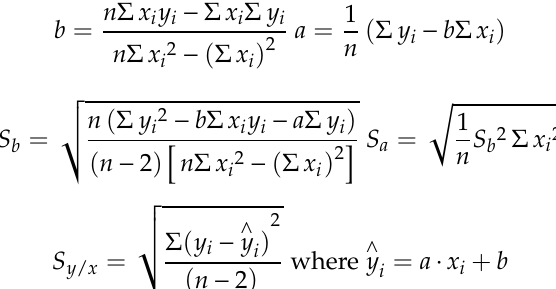
Figure 6. Emission spectrum of 3-aminoflavone in methanol at a concentration c = 0.1 µ g / mL in quartz cuvette with a thickness l = 1 cm. Fluorescence excitation λ ex = 365 nm; intensity of fluorescence emission I f is presented in RFU (relative fluorescence